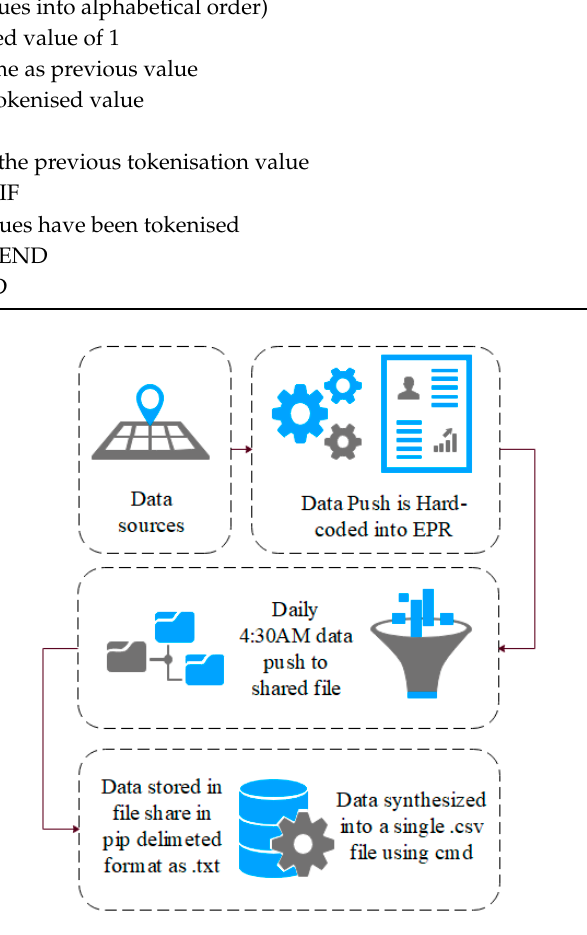
Figure 2. EPR data push process. Table 2. EPR audit sample data. Algorithm 1. Tokenisation algorithm